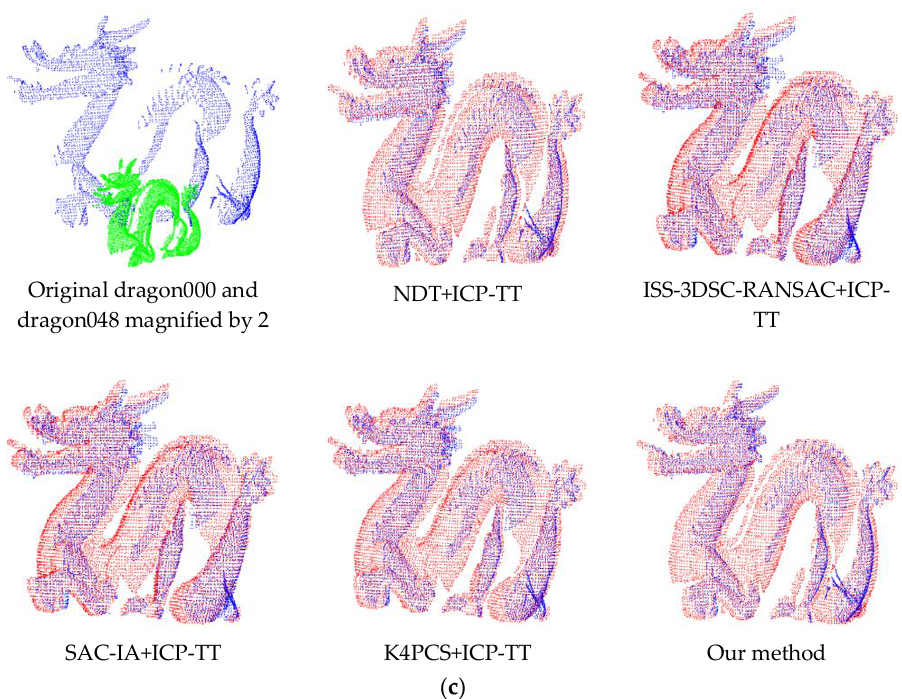
Figure 12. The registration results for scaled dragon data set of multiple registration methods with TT strategy. ( a ) The dragon000 and dragon048 magnified by 0.5 and registration results of five coarse-to-fine registration methods combined with TT strategy. ( b ) The dragon000 and dragon048 magnified by 1.5 and registration results of five coarse-to-fine registration methods combined with TT strategy. ( c ) The dragon000 and dragon048 magnified by 2 and registration results of five coarse-to-fine registration methods with TT strategy.